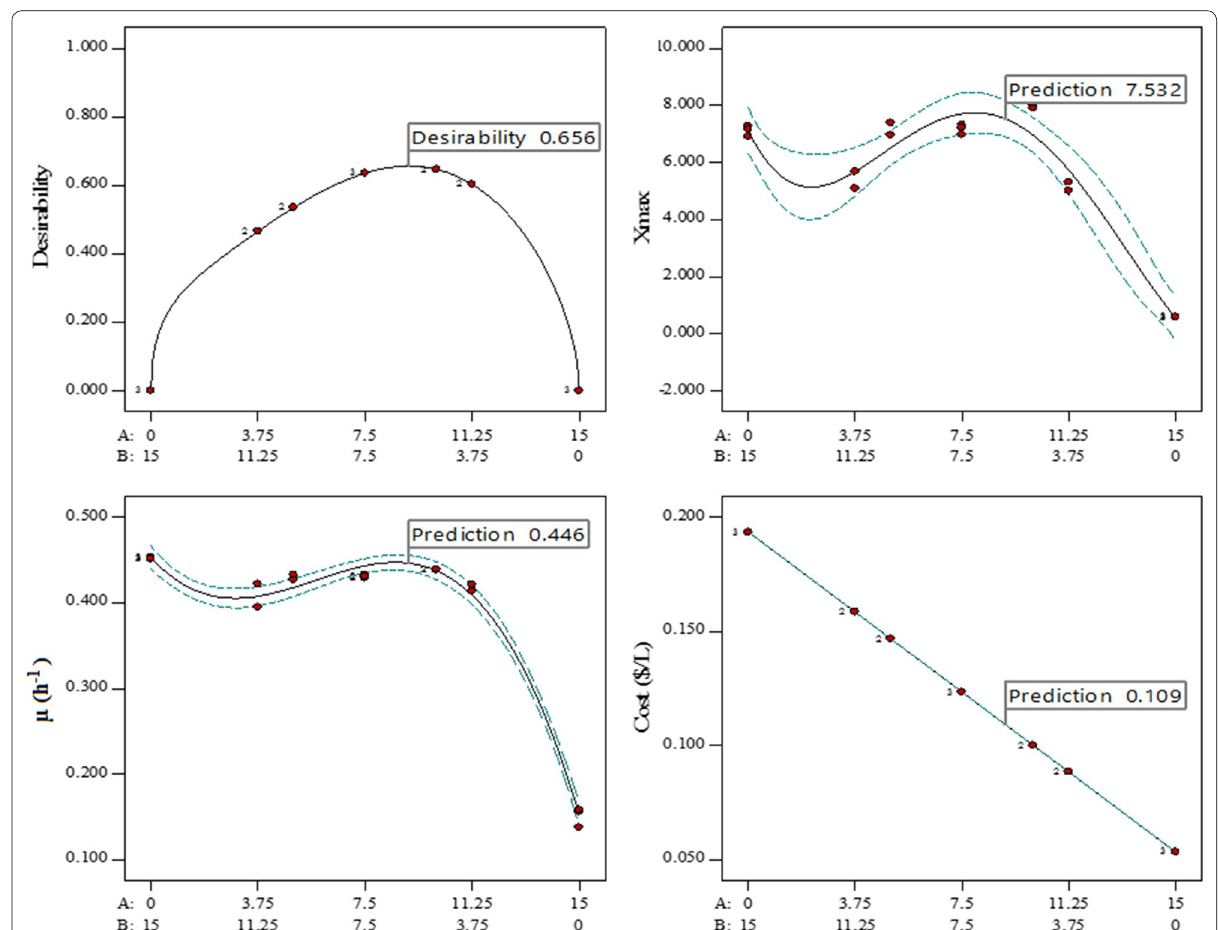
Fig. 3 Predicted optimum of the response variables from the optimization of the culture medium (H medium) concentration using the two‑component mixture. A: Sucrose. B: Yeast extract. All experimental points of the design contain the same proportion of phosphate buffer (100 mL/L). Design points